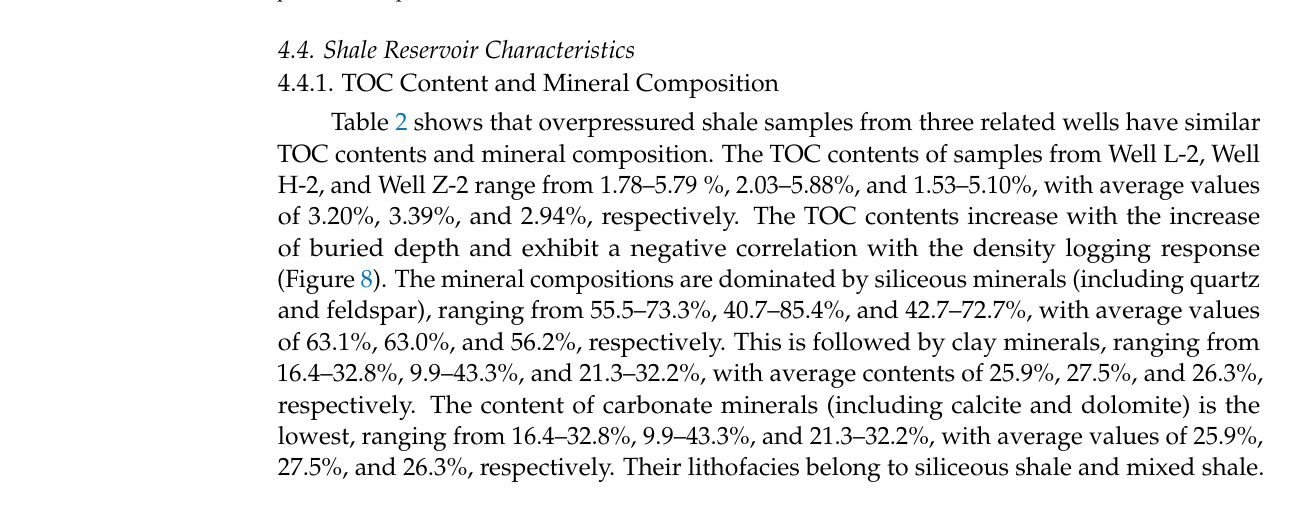
Table 2. Total organic carbon content, mineral composition, and total porosity data of three represen- tative Mbr 1 1 of Longmaxi Fm shale reservoirs located in the Southern Sichuan